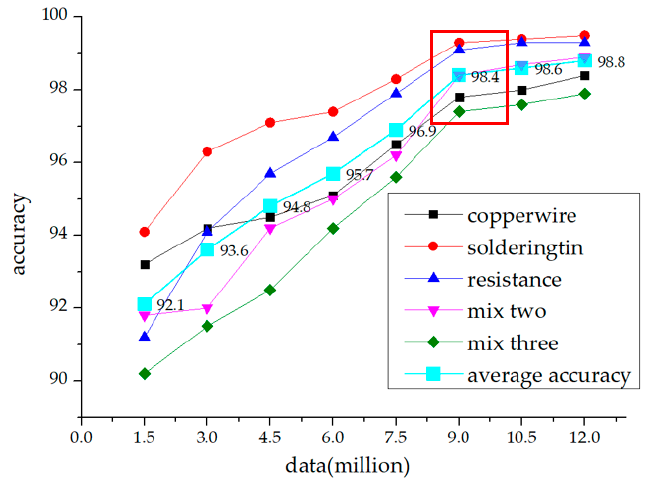
Figure 12. The elbow method happened when the samples were collected to